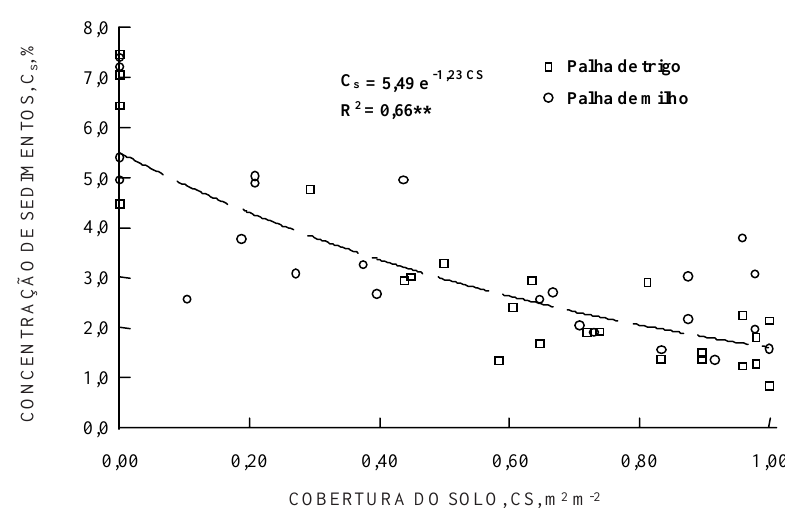
COBERTURA DO SOLO, CS, m 2 m Figura 1. Concentração de sedimentos na enxurrada em entressulcos, em função da cobertura do solo por palha de trigo e palha de milho.